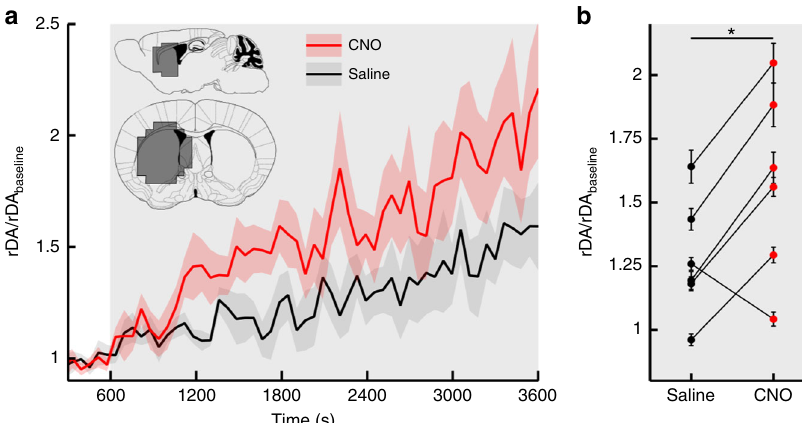
Fig. 9 Dopamine release assessed by [11C]raclopride-PET in hM3D Gq DAT mice. a Dopaminergic activity changes temporal variations of the [11C]raclopride signal ( rDA , mean±SEM). In n = 6 mice rDA was increased in the left striatum after chemogenetic activation with CNO (red line) in comparison to Saline injection (black line) at t = 600s. The gray background indicates the time after injection. b Average rDA (mean ± SEM) after t = 600 s in each mouse after saline and CNO injection. (Paired Student ’ s t -test: n = 6, t = 2.858, df = 5, * = p